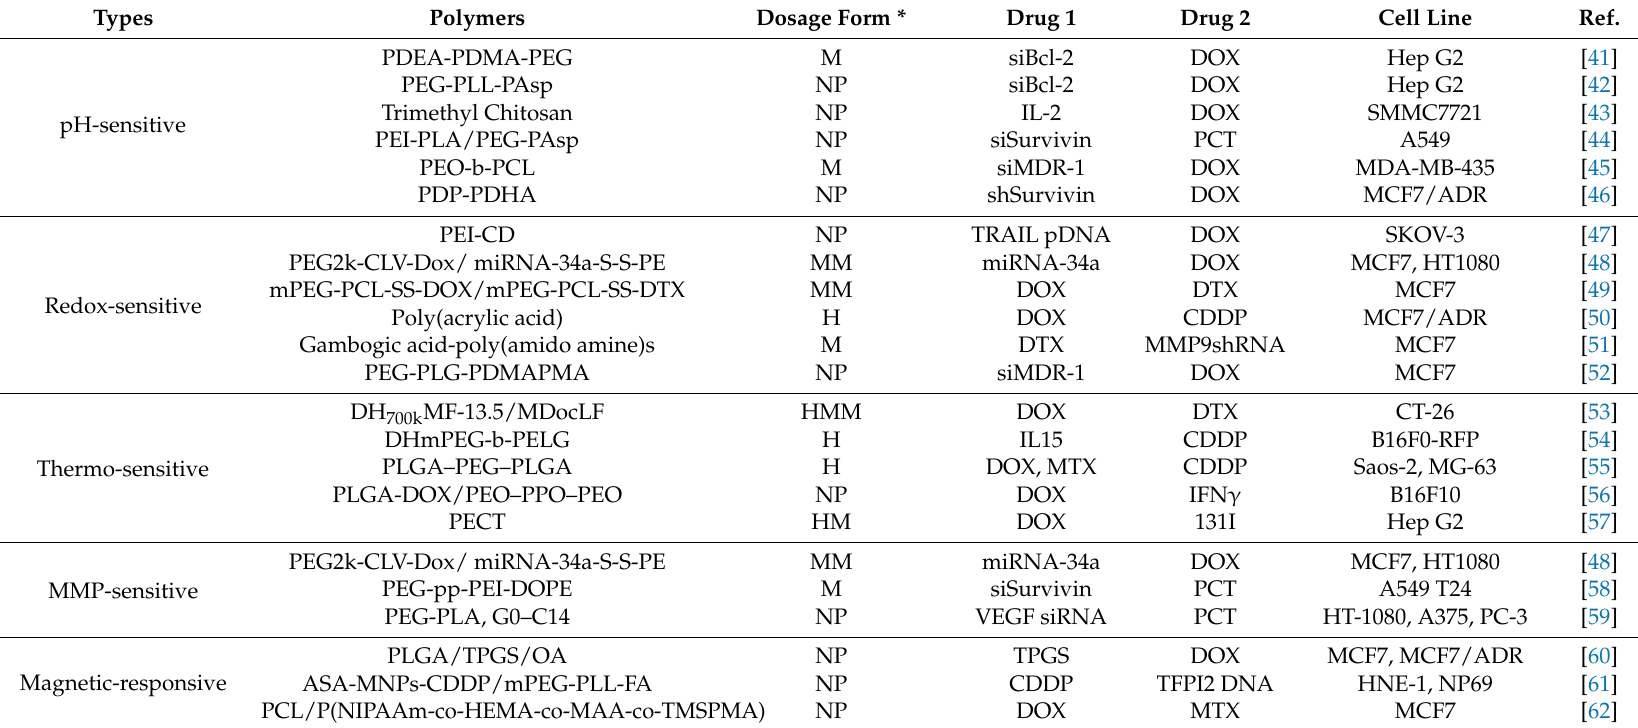
Table 1. Types of stimuli-sensitive polymers commonly used as co-delivery